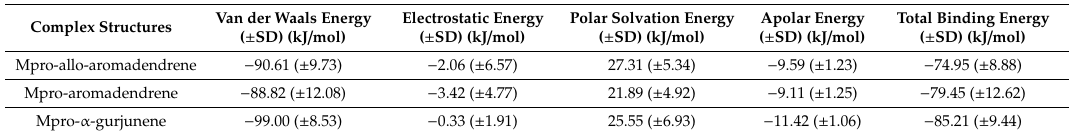
Table 3. Binding energy obtained using MM / PBSA technique of each complex along with contributions from van der Waals, electrostatic, polar and apolar solvation